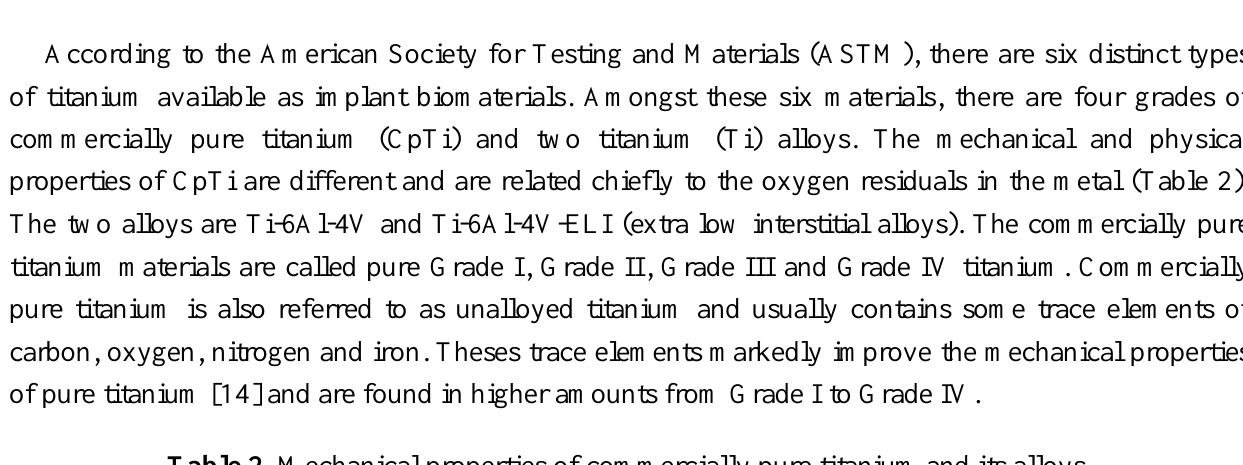
Table 2. Mechanical properties of commercially pure titanium and its